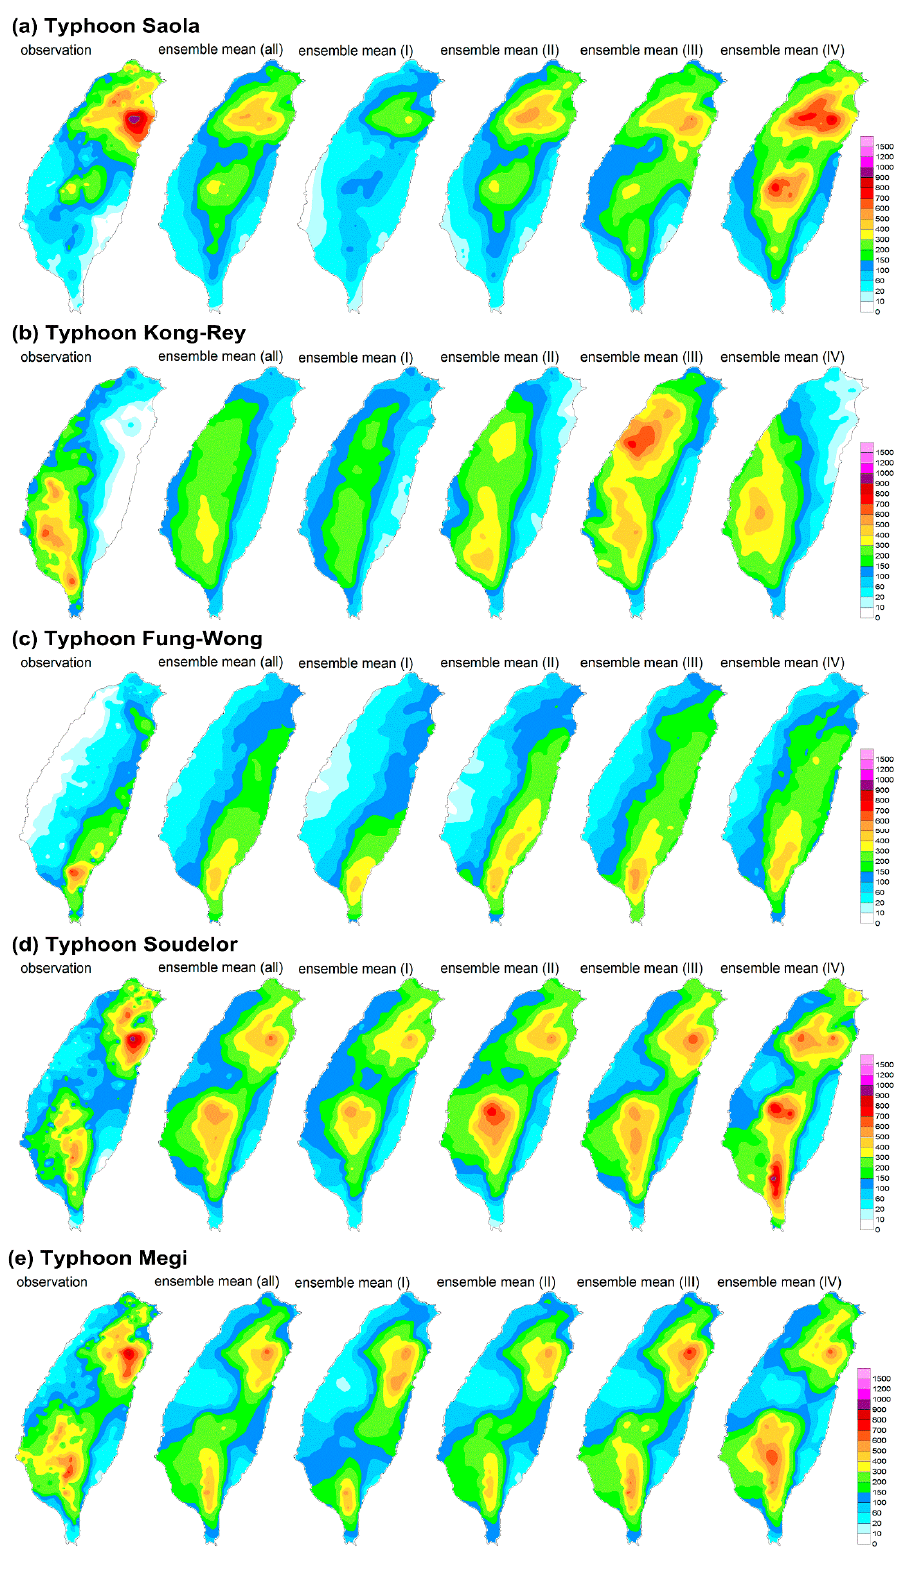
Figure 7. The observation and the ensemble means of corresponding clusters as well as all members, ( a ) Typhoon Saola; ( b ) Typhoon Kong-Rey; ( c ) Typhoon Fung-Wong; ( d ) Typhoon Soudelor; ( e ) Typhoon Megi.